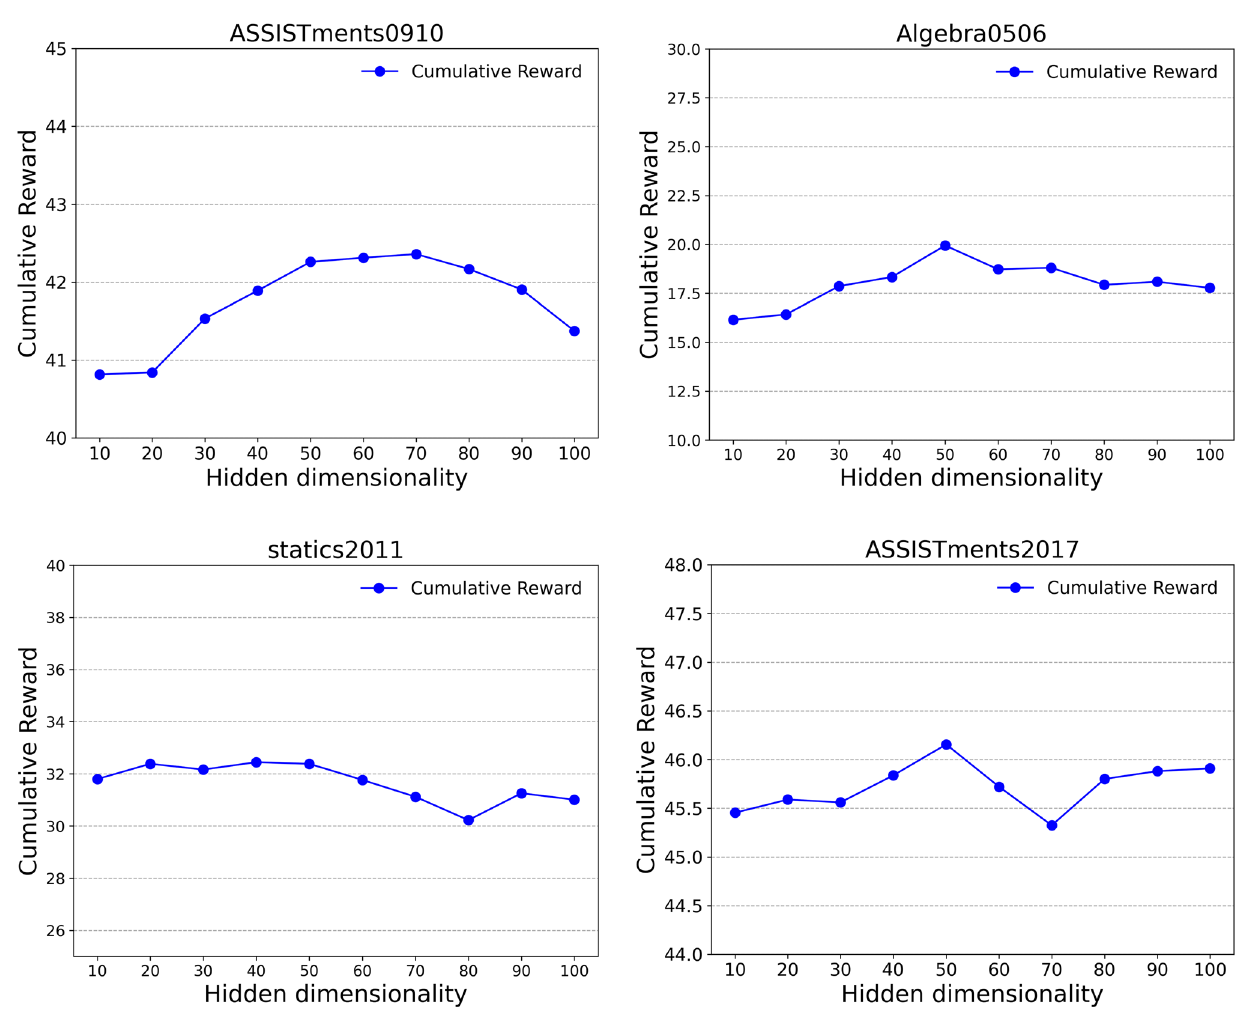
Fig. 13 Effect of the hidden dimensionalities for different datasets